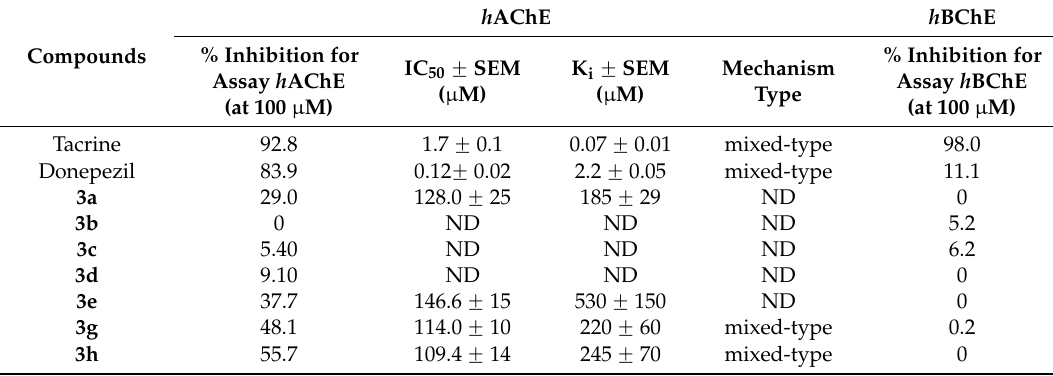
Table 1. Percentage of h AChE and h BChE inhibition (at 100 µ M compound concentration), calculated IC 50 values and inhibition constant (K i ) and mechanism of the action for hybrid compounds 3a – e and 3g – h . Data for reference drugs donepezil ( 1 ) and tacrine ( 2 ) are also